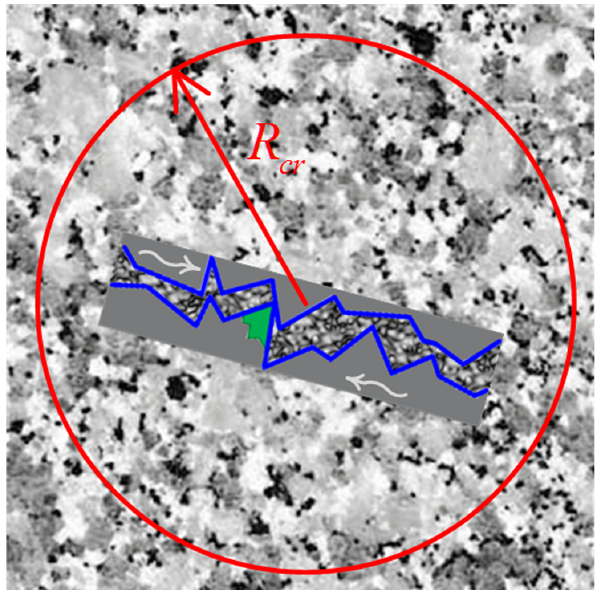
Fig. 1. A fault (blue lines) is embedded in an heterogeneous envi- ronment. The EQ preparation process at the first stage concerns an area of R cr radius around the fault where the heterogeneous media takes part in the fracture process, emitting MHz EME during the cracking of heterogeneous media. The symmetry breaking signals the transition from the phase of non-directional, almost symmetri- cal, cracking distribution to a directional localized cracking zone along the direction of the fault. The EQ is inevitable if and only when the asperities break (green highlighted area), emitting the kHz EME during the second stage, and then an EME silence